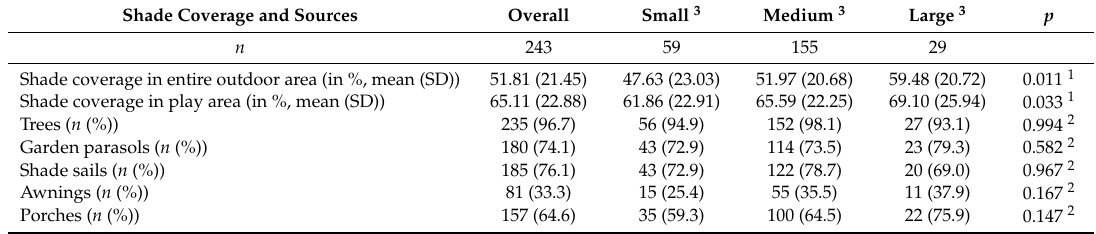
Table 1. Results from the on-site inspection of outdoor areas in 243 nurseries in Bavaria, southern Germany. Numbers represent mean values and standard deviation (SD) for the proportion of area covered by shade, and absolute numbers and percentages for the sources of shade.